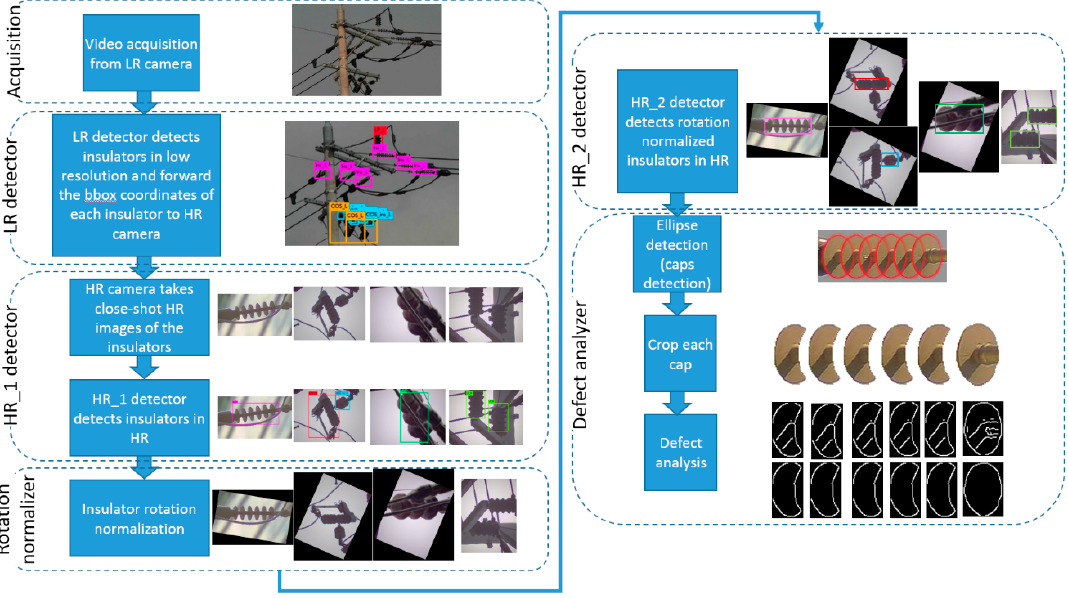
Figure 2. Overall system diagram of the proposed CNN-based electrical equipment inspection system.